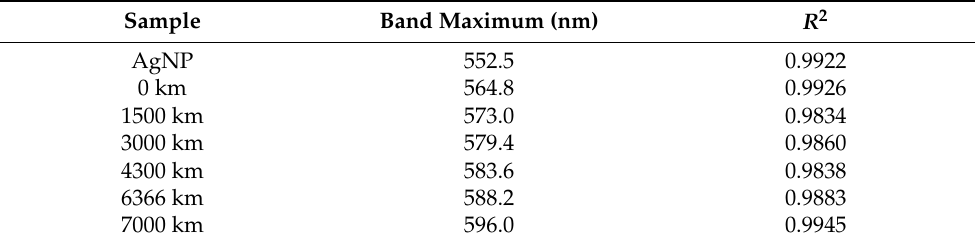
Figure 8. Normalized absorption spectra of AgNP and six degraded oil samples measured in the sensing prototype. Table 3. LSPR band maximum position of AgNP alone and after interaction with the oil samples and coefficients of determination obtained from the Gaussian fit applied to each